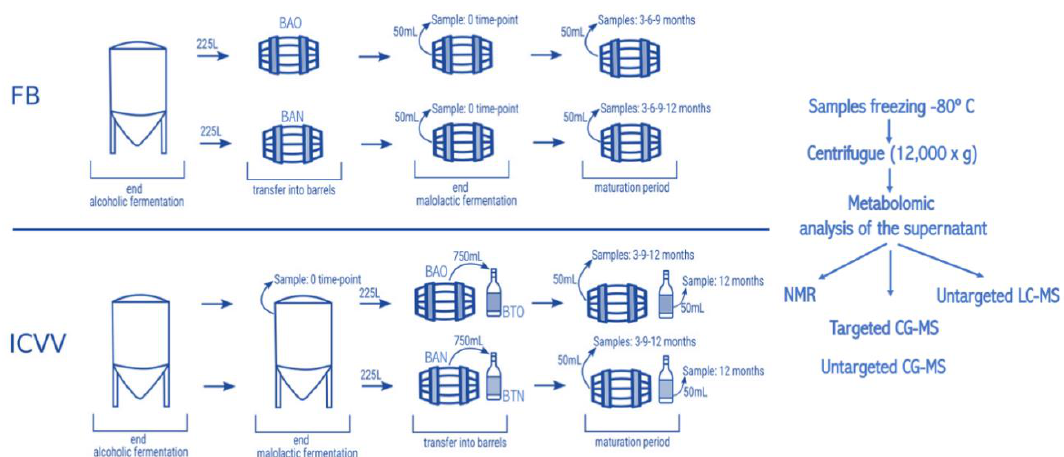
Figure 1. Schematic representation of the experimental setup. The BAN represents new barrels and the BAO the used ones, at the cellar Ferrer Bobet (FB) and cellar of “Instituto de Ciencias de la Vid y el Vino” (ICVV). Barrels of 225 L were sampled at different time-points, expressed in months, taking 50 mL of wine. In FB, the malolactic fermentation was performed inside the steel tank, whereas in ICVV it was performed inside the barrels. In addition, in ICVV the moment the wine was introduced in the barrels, a sample of 750 mL was taken and placed into glass bottles (BTN and BTO). The bottled wines were sampled after 12 months of maturation at cellar conditions.